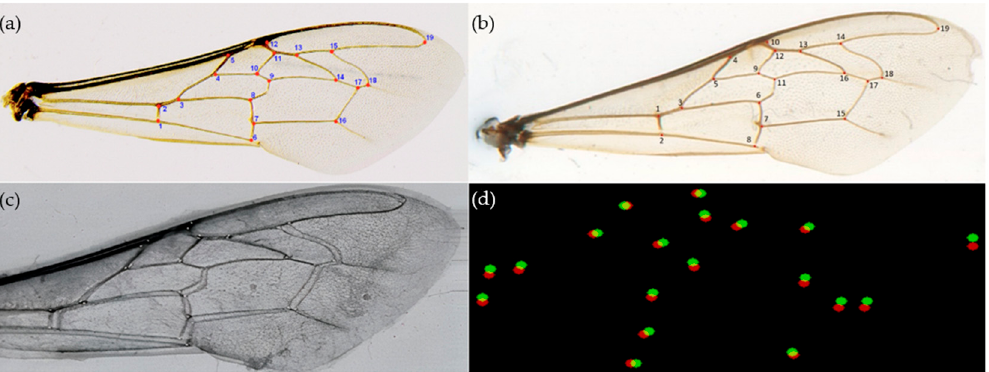
Figure 1. Right forewings of honey bee workers showing the 19 landmarks. ( a ) An example of a manually annotated image used for training the landmark segmenter. ( b ) Example of an image annotated automatically by the software DeepWings©. ( c ) Overlapping of the M-lineage subspecies Apis mellifera mellifera and Apis mellifera iberiensis right forewings, as extracted by the wing detector of DeepWings©. ( d ) Extracted landmarks of the two forewings, after Procrustes alignment, showing the positional deviations between these two honey bee subspecies.